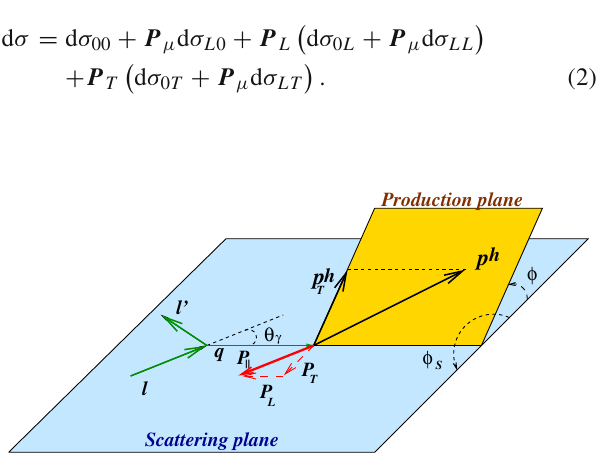
Fig. 1 The SIDIS kinematics shown for target deuteron polarisation P (cid:4) antiparallel to the beam